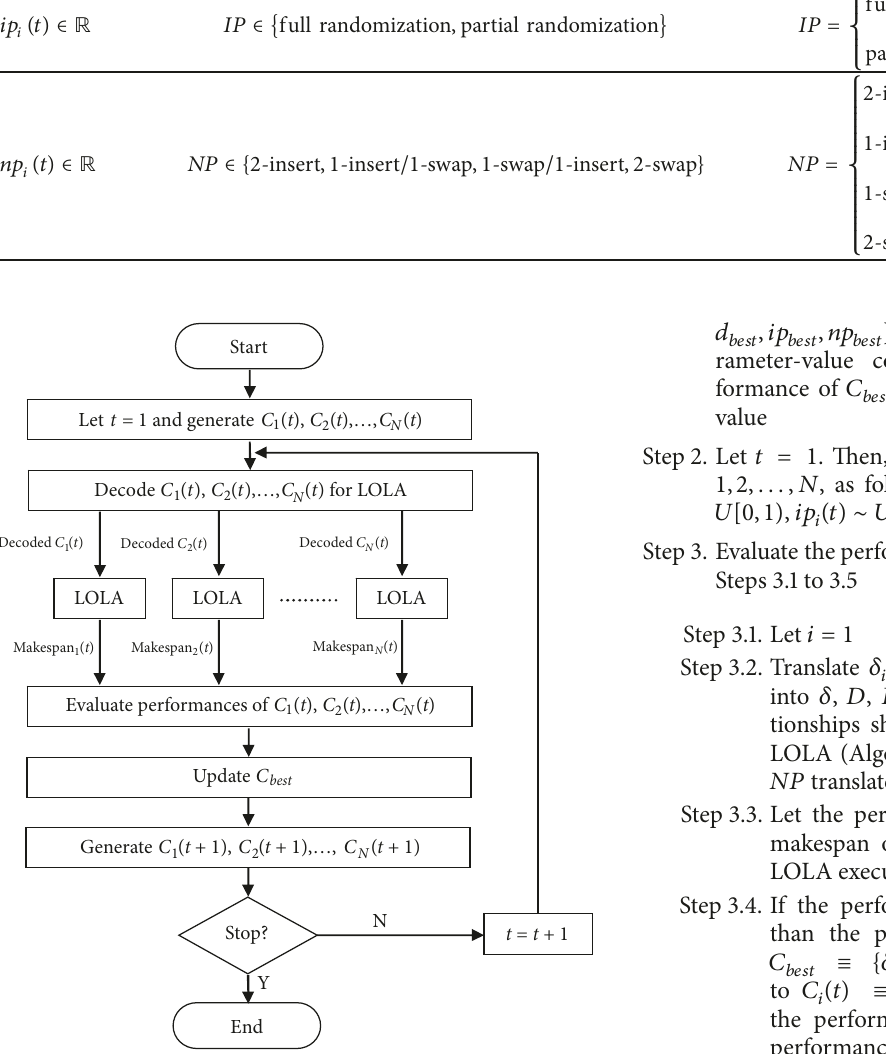
Figure 1: Flow chart of the UPLA combined with LOLA. that, Step 3 evaluates the performance of each 𝐶 𝑖 (𝑡) , where 𝑖 = 1, 2, . . . , 𝑁 , and updates 𝐶 𝑏𝑒𝑠𝑡 . Step 4 then updates 𝐶 (𝑡) to 𝐶 𝑖 𝑖 ( t + 1); however, all values in C 𝑖 ( t + 1) will be randomly regenerated once for every 25 iterations for the purpose of diversifying the population. Step 5 finally checks the condition to stop or continue the next